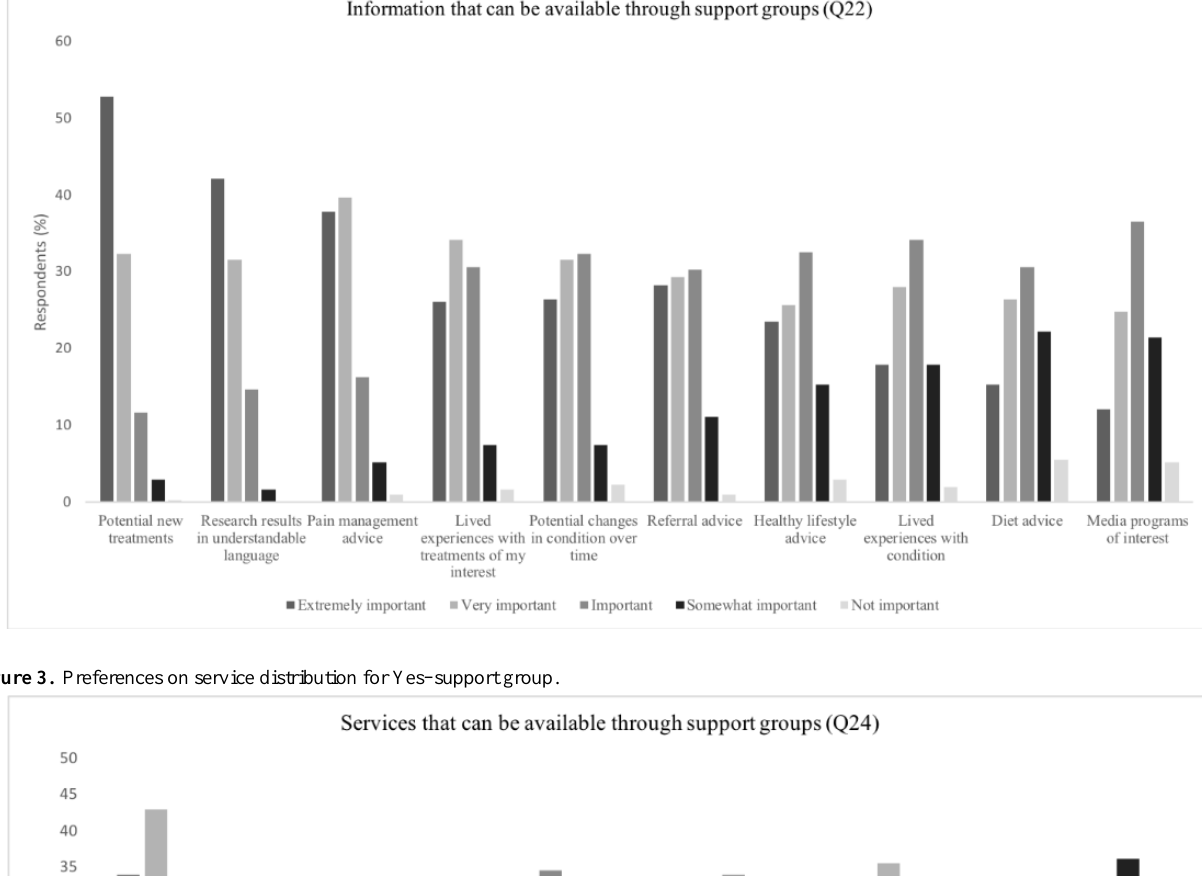
Figure 2. Preferences on information distribution for Yes–support group.